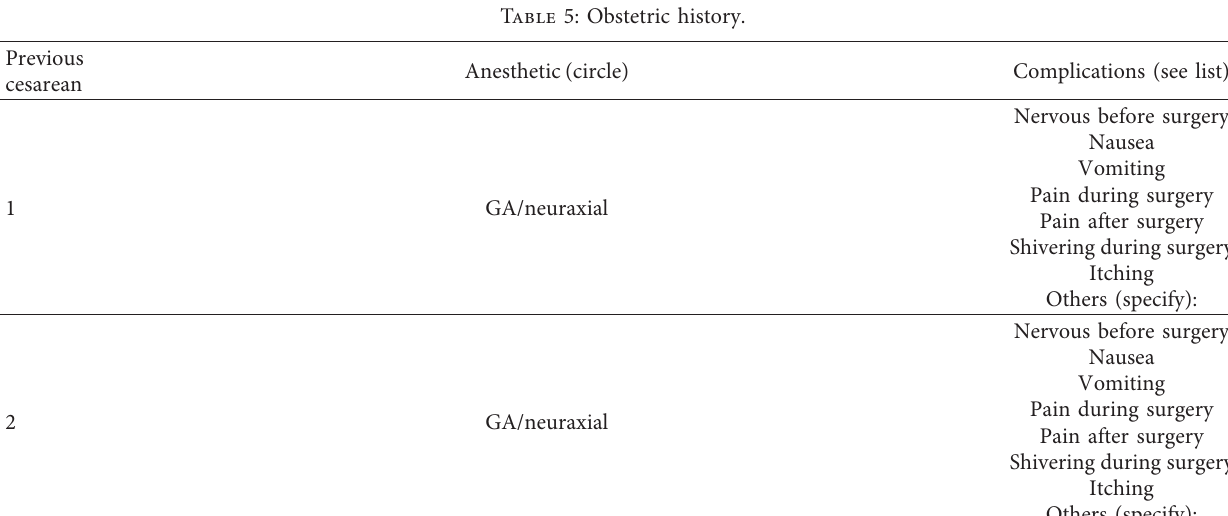
Table 5: Obstetric